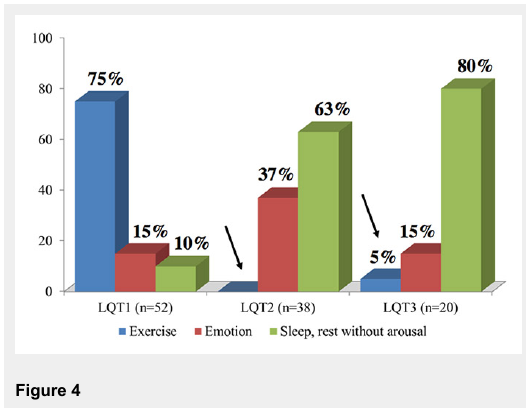
Triggers for lethal cardiac events in LQT1, LQT2 and LQT3 patients. The arrows indicate the rare occurrence of these events during sympathetic activation in patients without mutations affecting the I Ks current. (Modified from reference